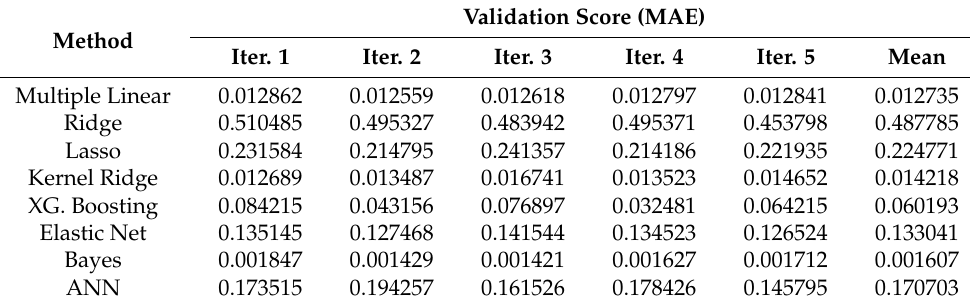
Table 3. K-Fold Cross-Validation scores for power prediction.